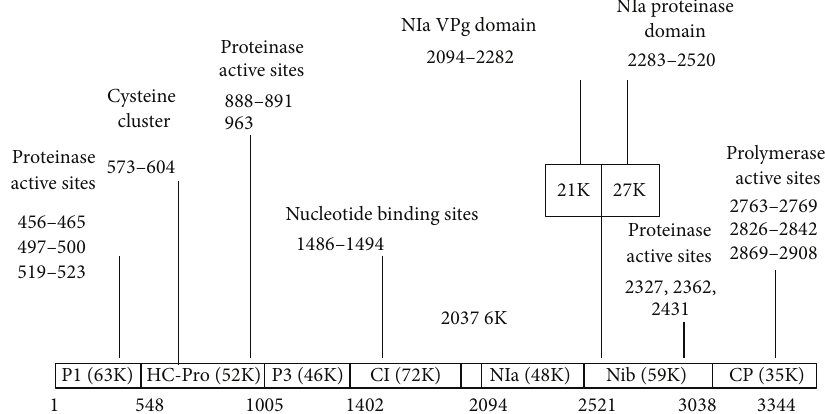
Figure 1: The map of the PRSV polyprotein. Specific motifs are indicated, solid bars indicate cleavage sites in the polyprotein, and the dashed line indicates the potential internal cleavage site of the NIa